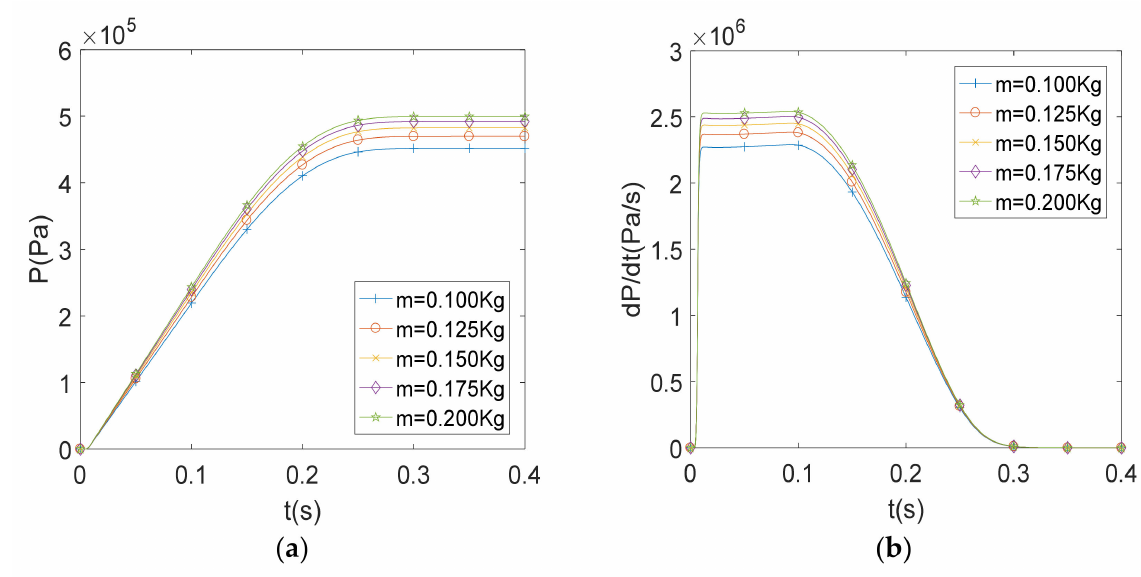
Figure 14. Influence of the ratio of upper and lower surface areas of piston on pressure change rate: ( a ) pressure response; ( b ) pressure change rate response.